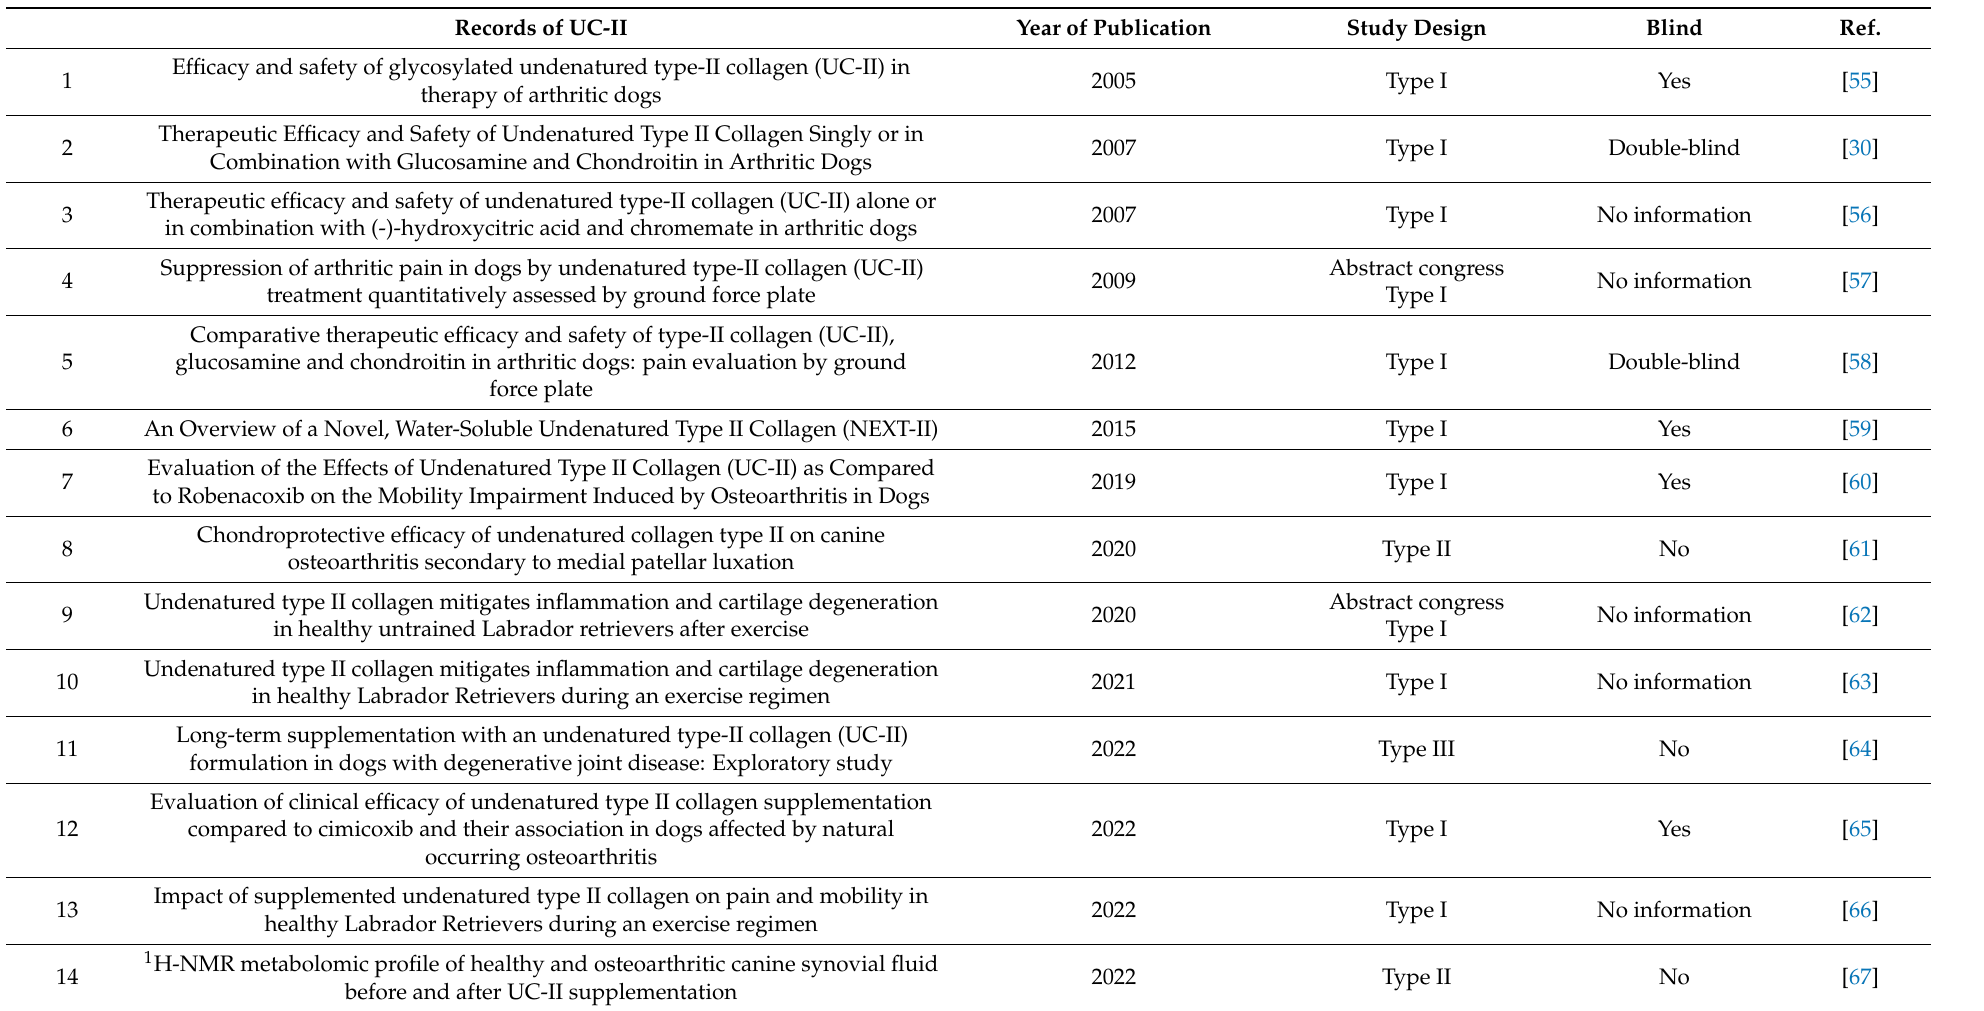
Table 2. Records included in the review based on the search performed regarding undenatured type II collagen for managing clinical signs of osteoarthritis and joint support in dogs.